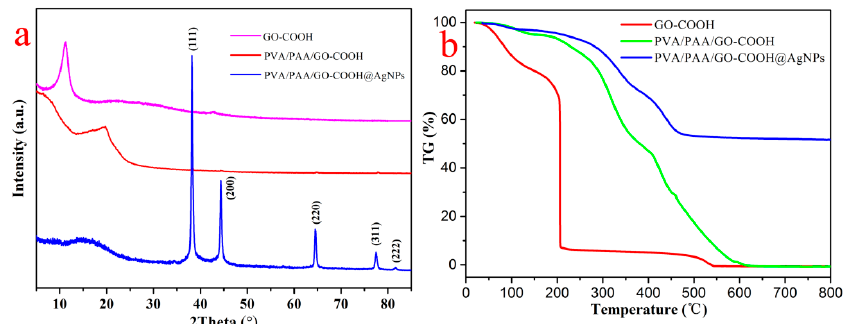
Figure 4. X-ray diffraction patterns ( a ) and TG curves ( b ) of the prepared GO-COOH solid, PVA/PAA/GO-COOH nanocomposite, and PVA/PAA/GO-COOH@AgNPs nanocomposite at modified time of 1 h.